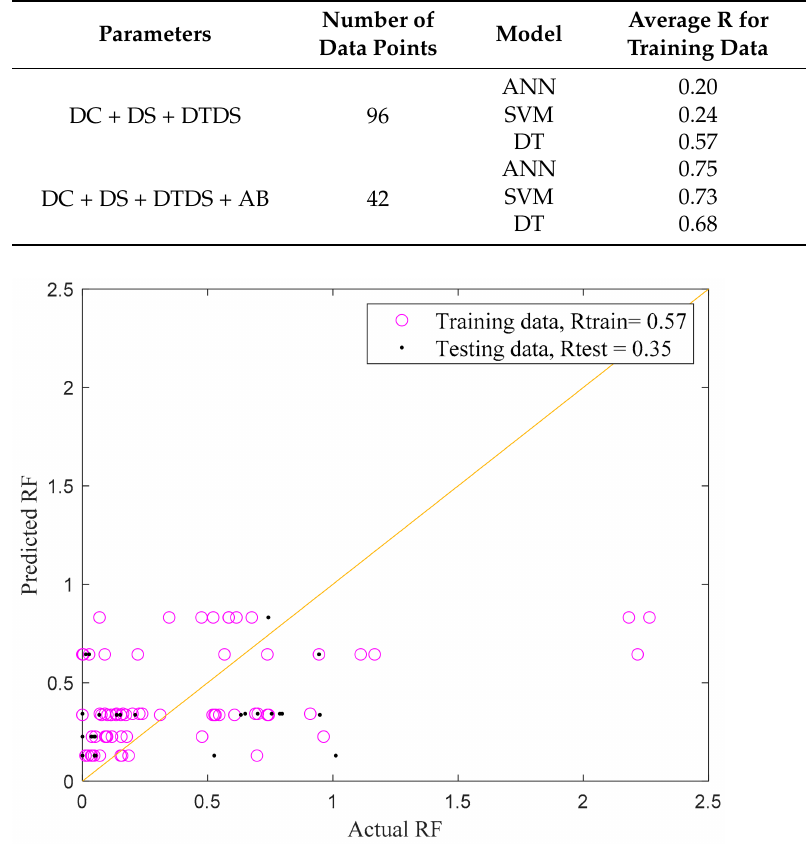
Table 7. The results obtained from three ML models for different sets of parameters.